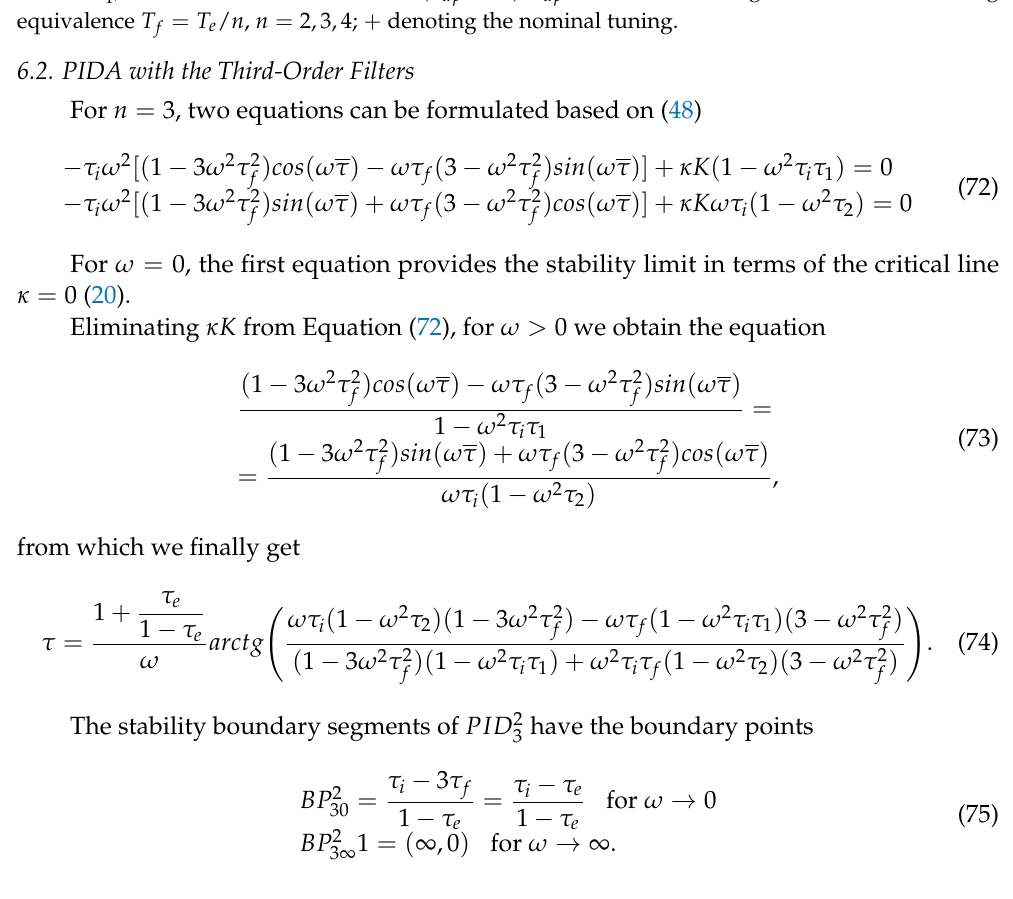
) and filtered PIDA controllers ( PID 2 0